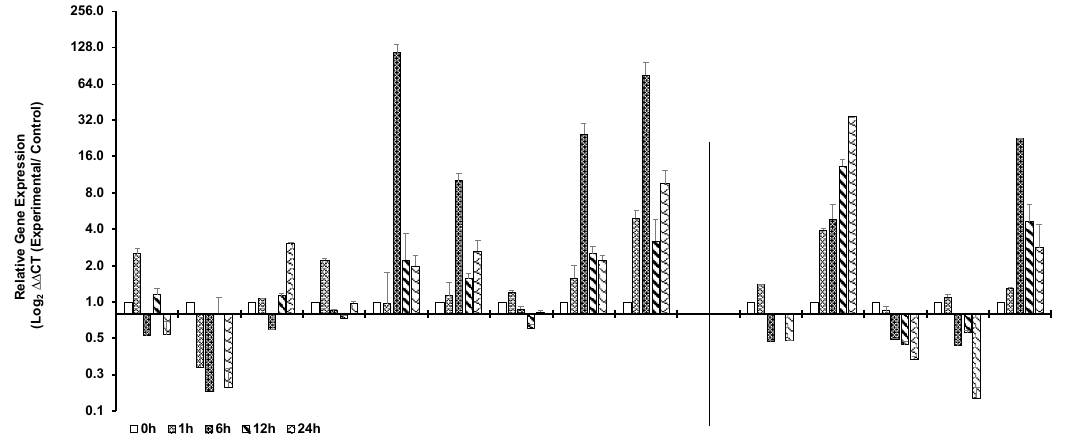
Figure 4. qRT-PCR analysis of tomato ( S. lycopersicum cv. Ailsa Craig) LOX gene family members in response to cold stress. Graphical representation of qRT-PCR data of tomato 9- LOX genes and 13-LOX genes in response to cold treatment at 4 °C for up to 24 h. A non-treated control (0 h) was used as calibrator in qRT-PCR data calculation and for defining statistical significance of treatment data points at levels * p < 0.05, ** p < 0.01 and *** p < 0.001. Details are given in Figure S2. A minimum of three biological replicates, where each biological replicate was comprised of two technical replicates, were used for each time point. Housekeeping genes, SlTIP41 and SlUBI3 , were used to normalize the expression of target genes.